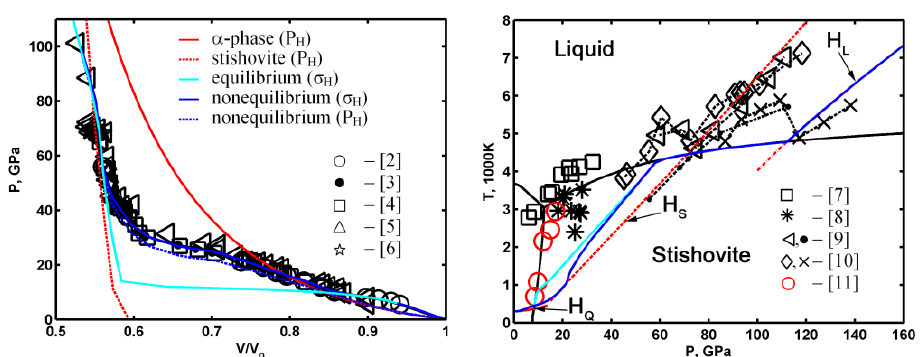
Fig. 1. Quartzite shock compressibility (left) and quartzite phase diagram from EOS [1] (right). Markers show experimental data, lines show calculated